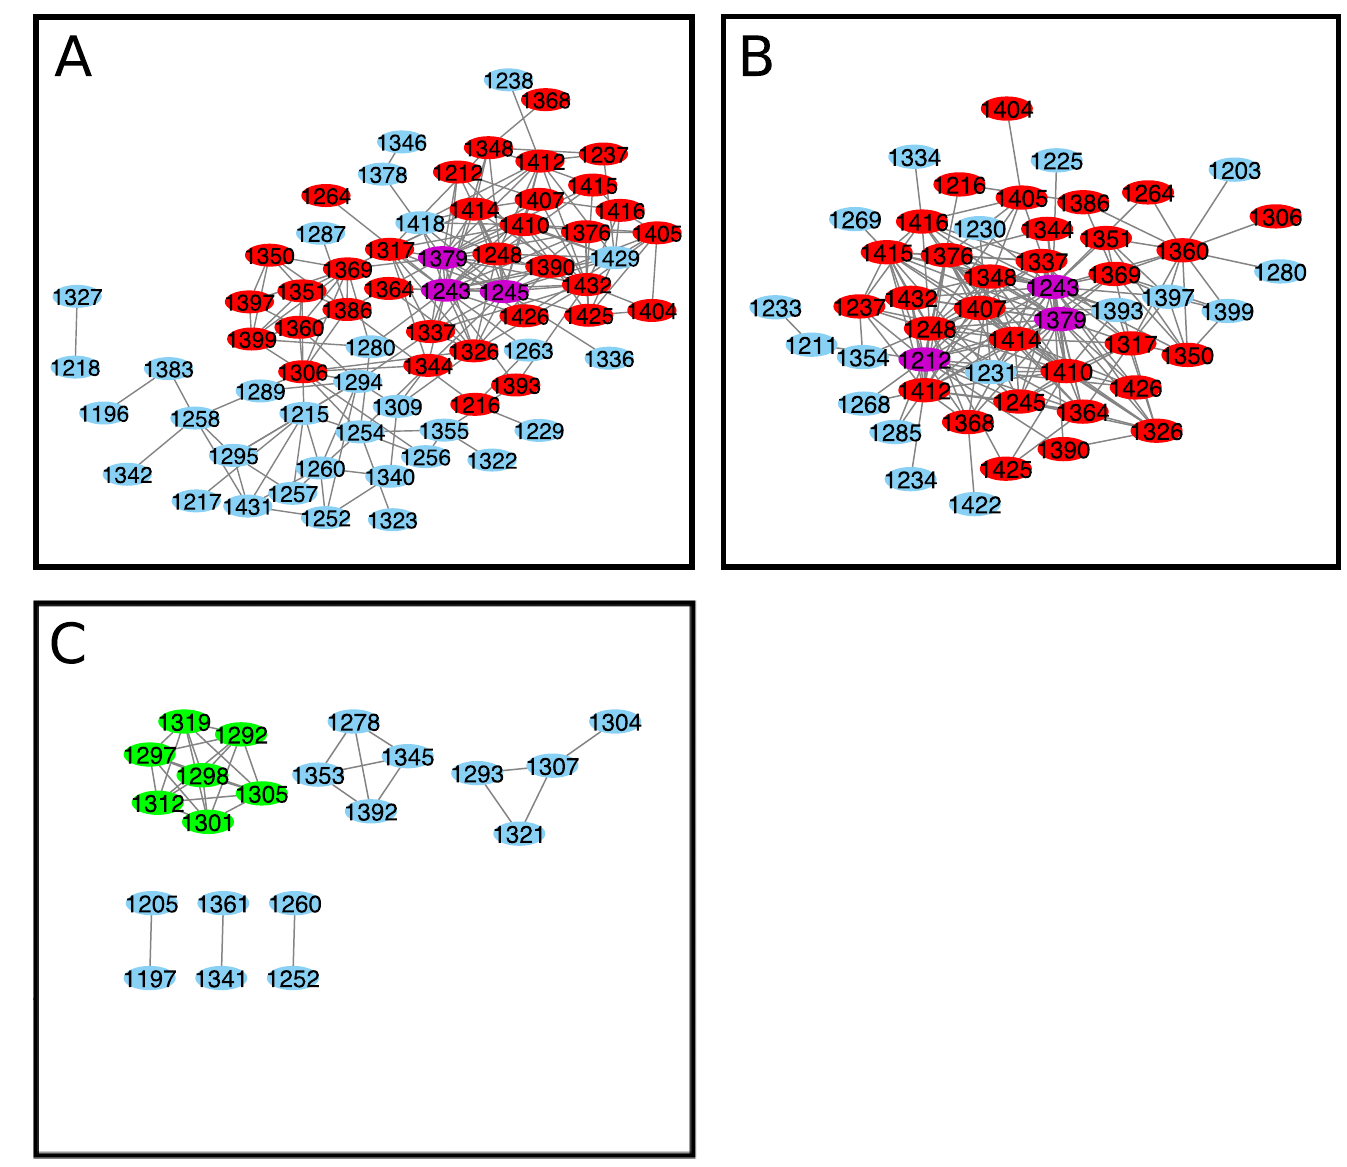
Fig 6. NBD2 cytoscape interaction map for N1303T perturbation analysis. (A) ELSC (N1303T) coupling matrix (B) OMES (N1303T) coupling matrix (C) McBASC (N1303T). Nodes that are central and overlap in all analysis are colored purple. Nodes that overlap in all analysis are colored red, and central nodes are colored green.